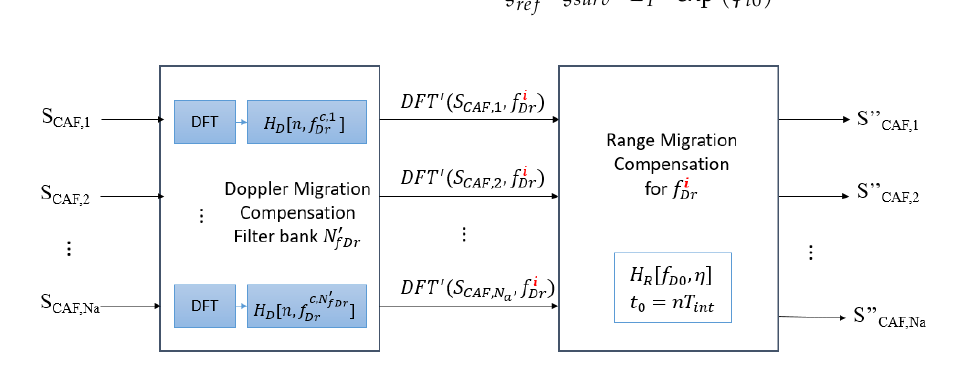
Figure 9. Range and Doppler migration compensation scheme.